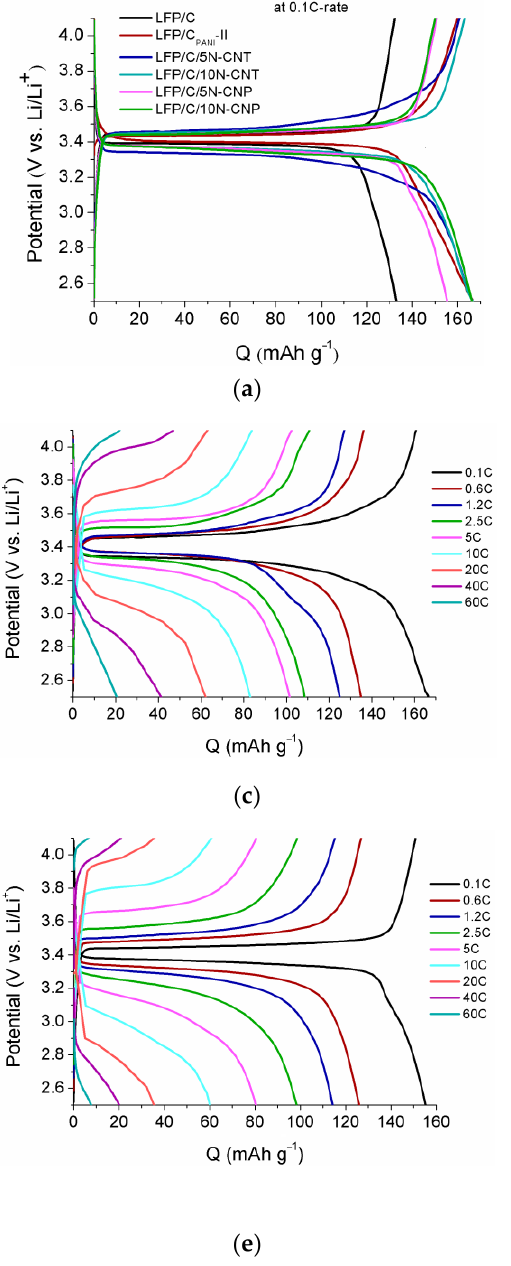
Figure 6. Initial charge – discharge curves of all the samples at a 0.1 C-rate ( a ), charge – discharge profiles at various C-rates for LFP/C PANI -II ( b ), LFP/С/5N -CNT ( c ), LFP/С/10N -CNT ( d ), LFP/С/5N -CNP ( e ), and LFP/С/10N -CNP ( f ).